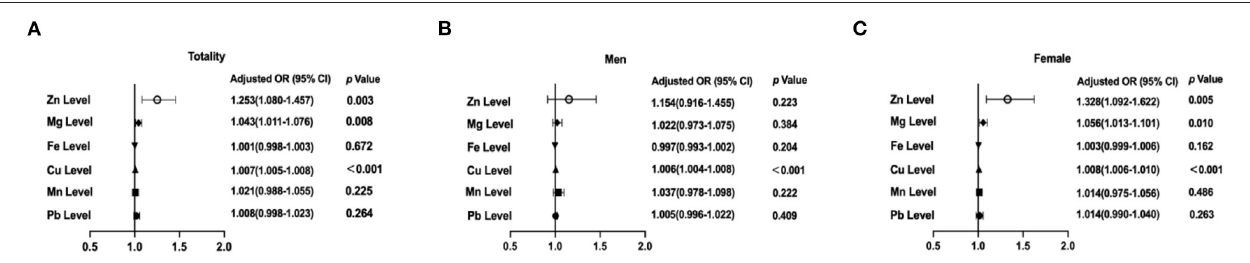
FIGURE 2 | Associations of selected trace elements levels with the prevalence of thyroid nodules (TNs) among the participants. (A) Selected trace elements levels and the prevalence of TN in total participants; (B) Selected trace elements levels and the prevalence of TNs in males; (C) Selected trace elements levels and the prevalence of TNs in females. In the total population, the model was adjusted for model 1. In stratified analysis by sex, the model was adjusted for age,